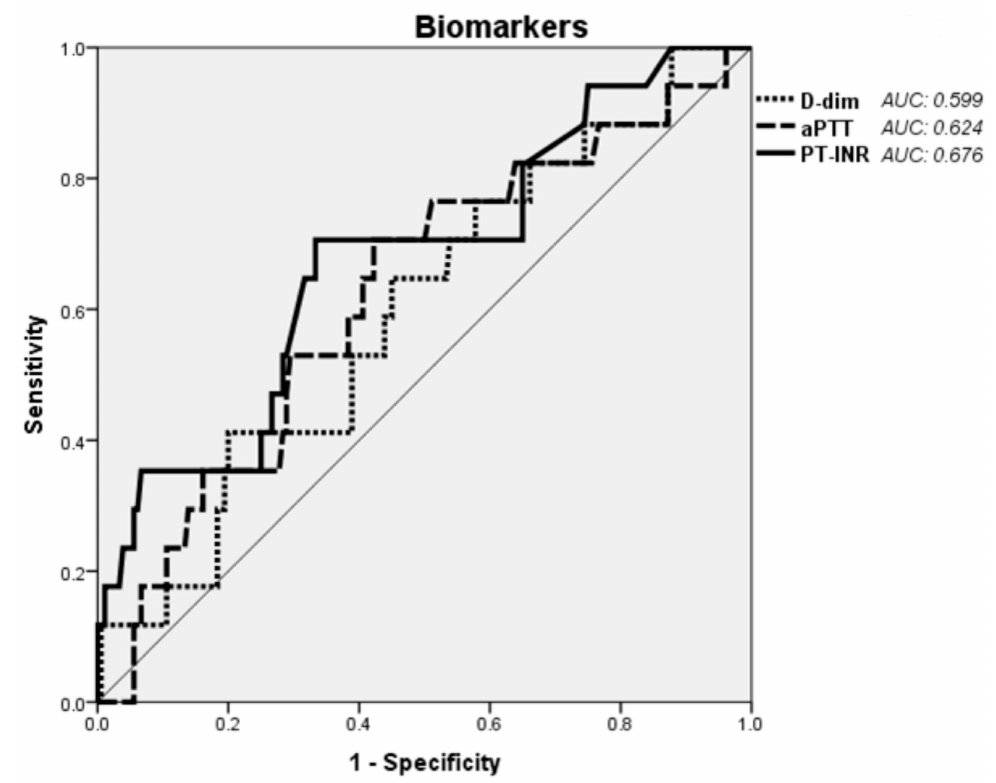
Figure 1. Receiver operating characteristic curve analysis of the predictive performance of three hemostasis parameters on in-hospital mortality of IE. Abbreviations: D-dim: D-dimers; aPTT: activated partial thromboplastin time; PT-INR: prothrombin time international normalized